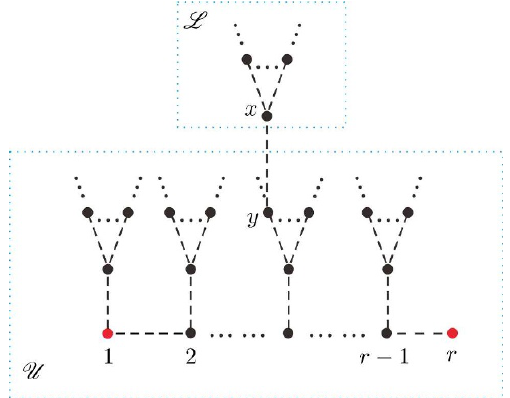
Figure 18 . Relative positions of nodes in a graph G which is determined by U , L and x 2 U , y 2 L n f r g can be characterized by dashed lines with no